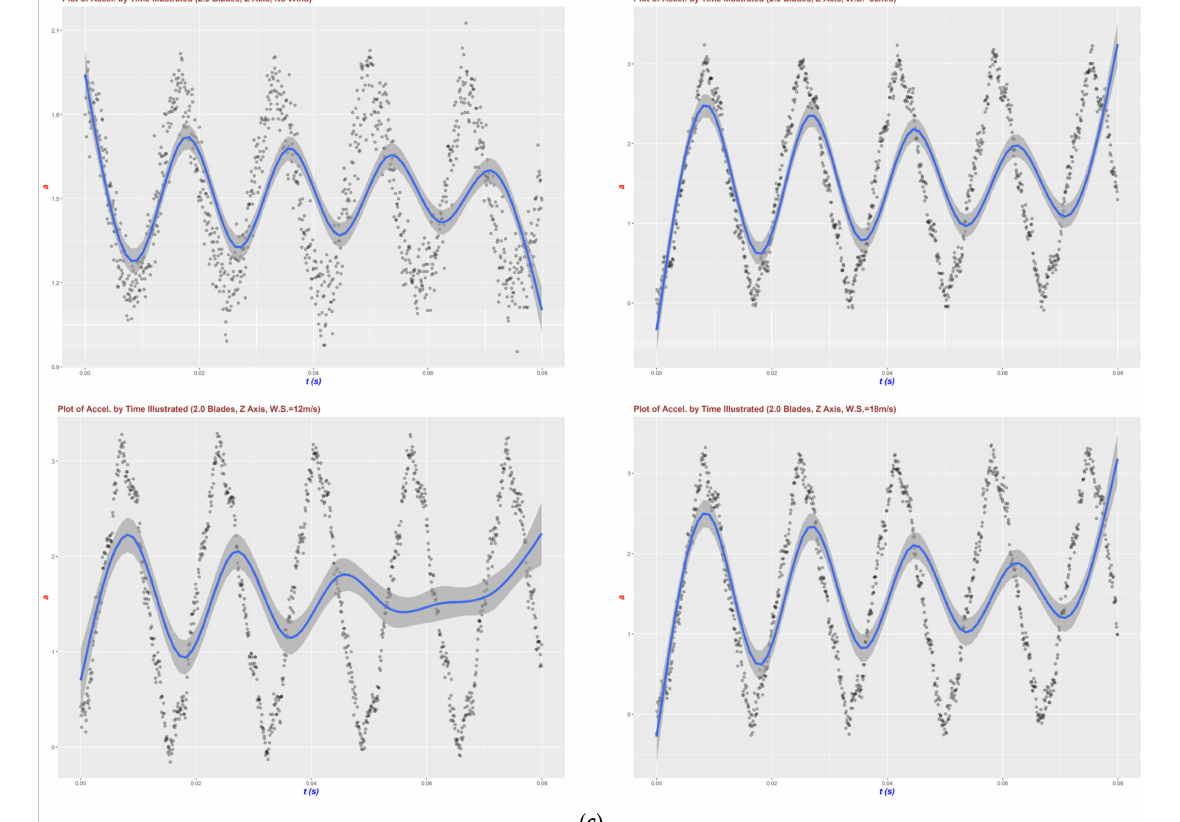
Figure A6. Magnitude and trend of acceleration for the 2.0-blade (one blade missing) turbine. ( a ) Based on datasets recorded along the X axis with different wind-speeds imposed. ( b ) Based on datasets recorded along the Y axis with different wind-speeds imposed. ( c ) Based on datasets recorded along the Z axis with different wind-speeds